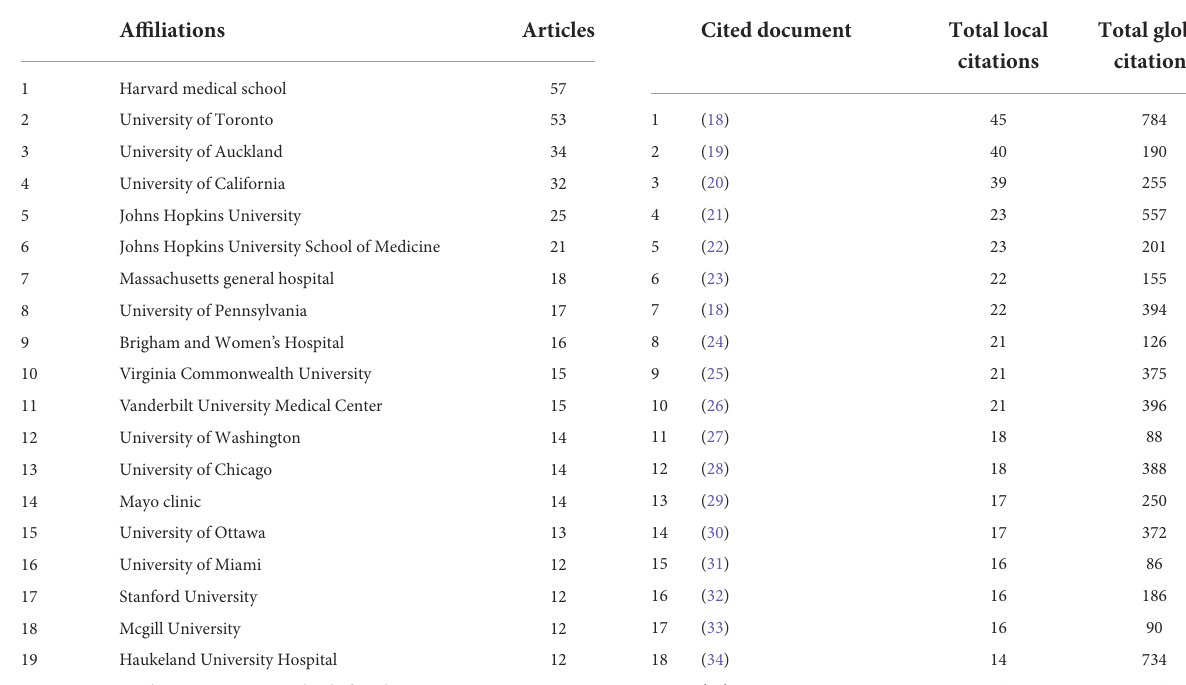
TABLE 5 The top 20 leading institutions regarding publications and citations liked to the IOM report.